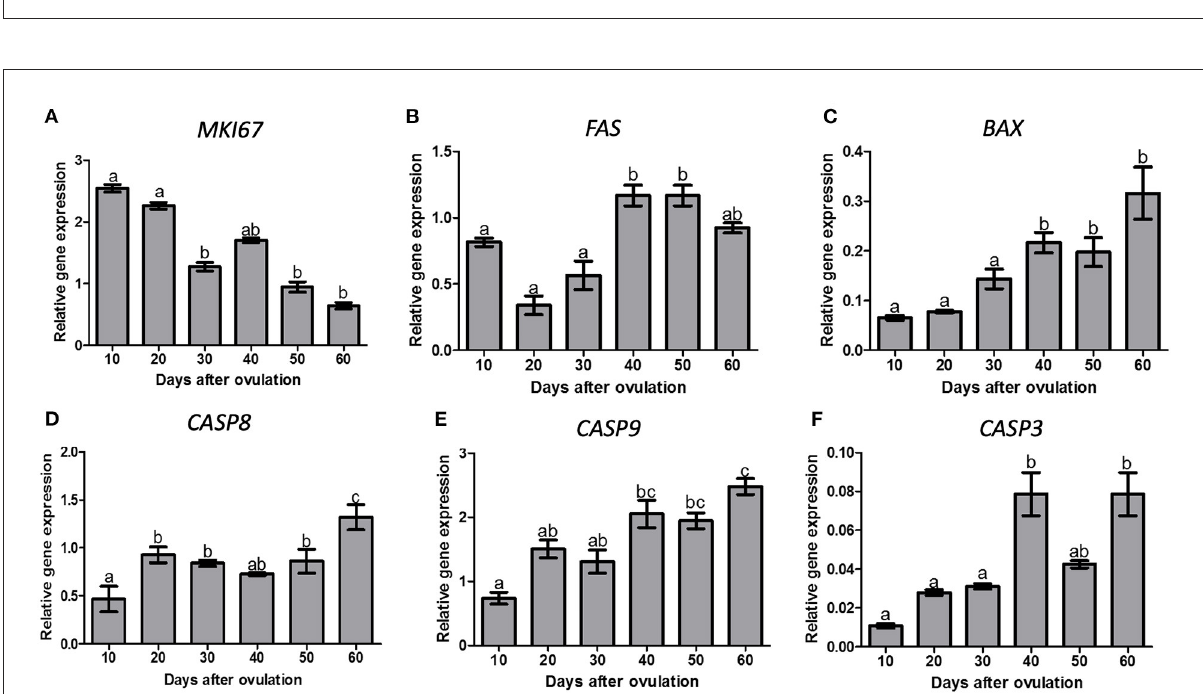
FIGURE3 Gene expression of, MKI67 (A) , FAS (B) , BAX (C) , CASP8 (D) , CASP9 (E) and CASP3 (F) in canine CL during diestrus (10 to 60 days p.o.). Data are presented as mean ± standard error of relative gene expression ( n = 4 or 5 animals/group). Bars with different letters indicate significant differences among groups ( P <